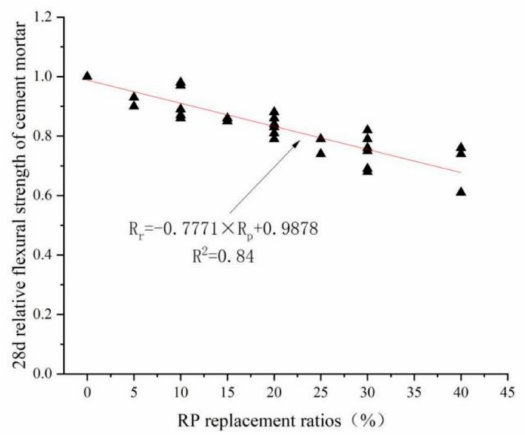
Figure 19. Graph of 28 d relative flexural strength of cement mortar under different replacement rates of RP